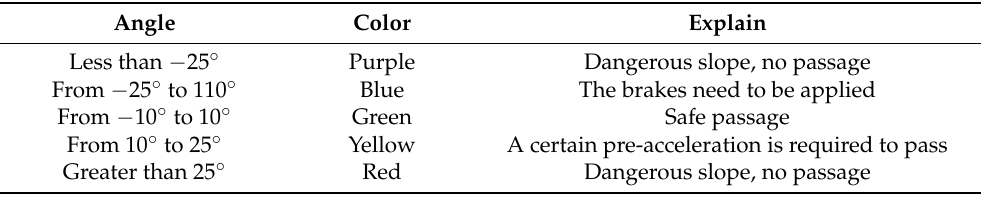
Table 1. Mark point classification.